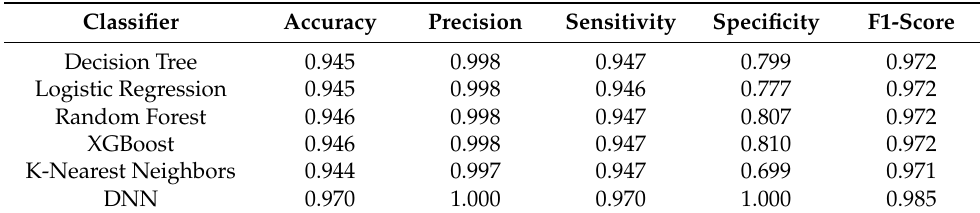
Table 7. Performance comparison of the proposed models for mortality rate prediction of COVID- 19 patients.